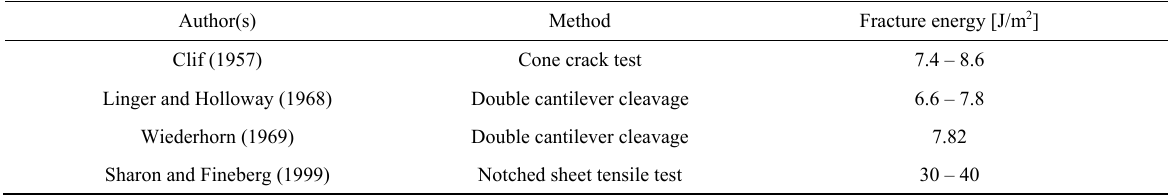
Table 1: Fracture energy of soda lime silicate glass in ambient